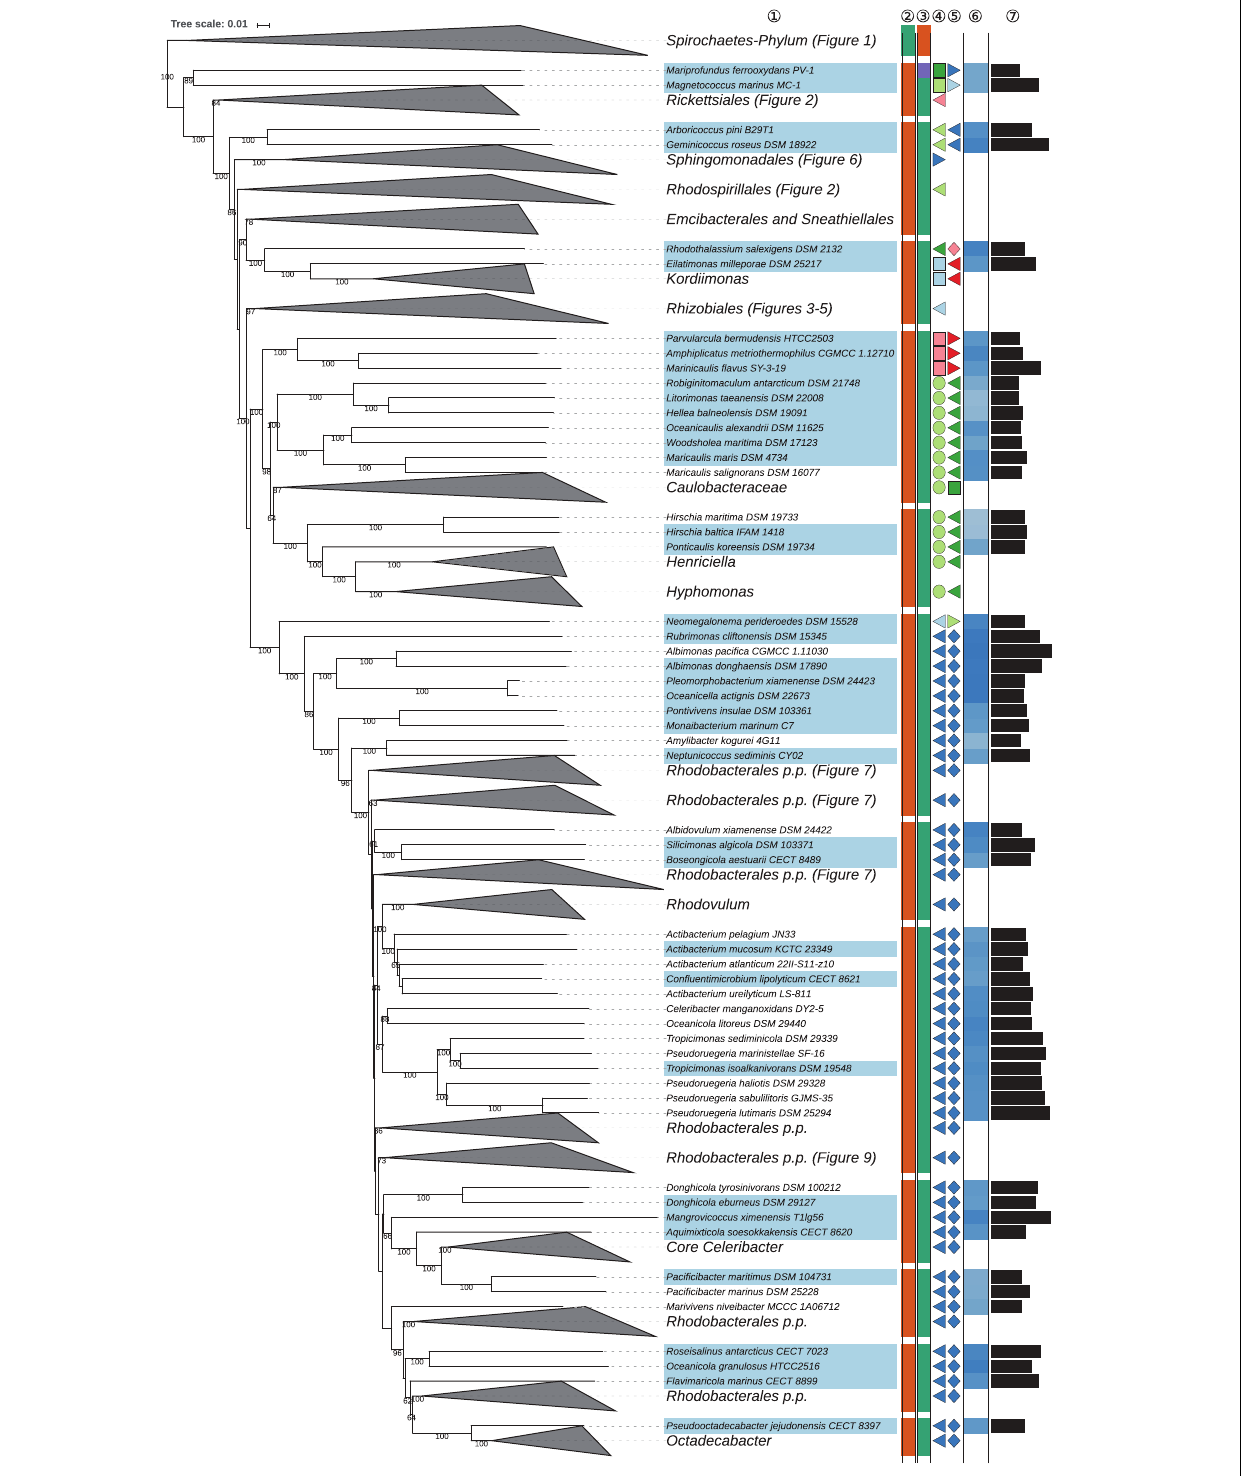
FIGURE 8 | Seventh part of the GBDP tree shown in Figure 1 , focussing on Caulobacterales , Parvularculales and parts of Rhodobacterales . Tip labels with light-blue background indicate type species of genera, colors and symbols to the right of the tips indicate, from left to right, phylum, class, order, and family; for details and abbreviations see Figure 1 . The blue color gradient indicates the G+C content as calculated from the genome sequences, followed by black bars indicating the (approximate) genome size in base pairs.